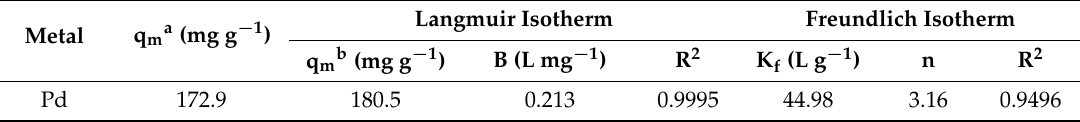
Table 4. Langmuir and Freundlich isotherm parameters of Et- N -Cu(BDC-NH 2